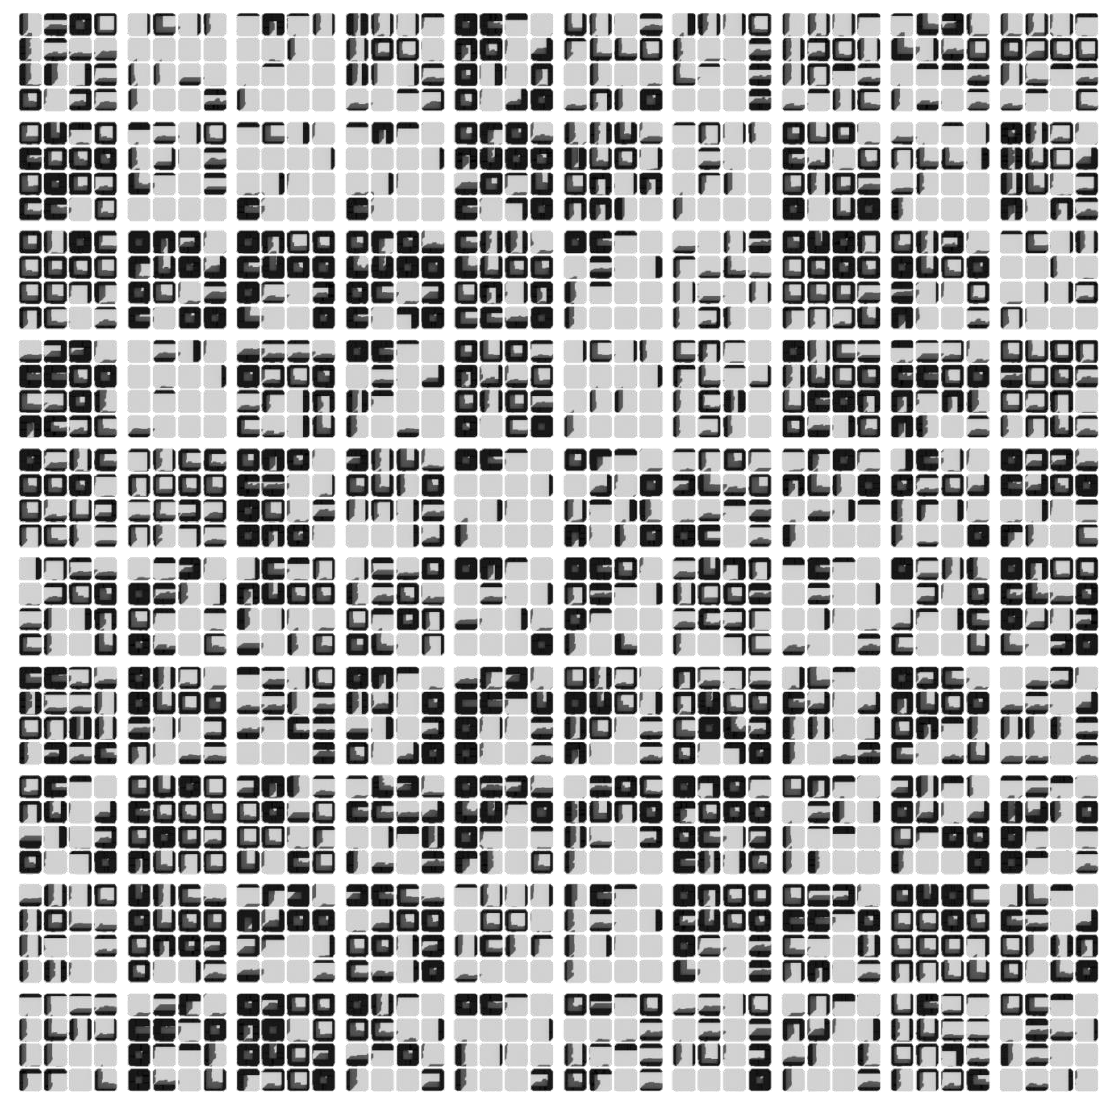
Figure 7. Render with shadow analysis from the last generation (num. 100) that contains 100 individuals (Superblocks). Individuals have been arranged in a square grid for visual purposes. Each individual is composed by 16 blocks.